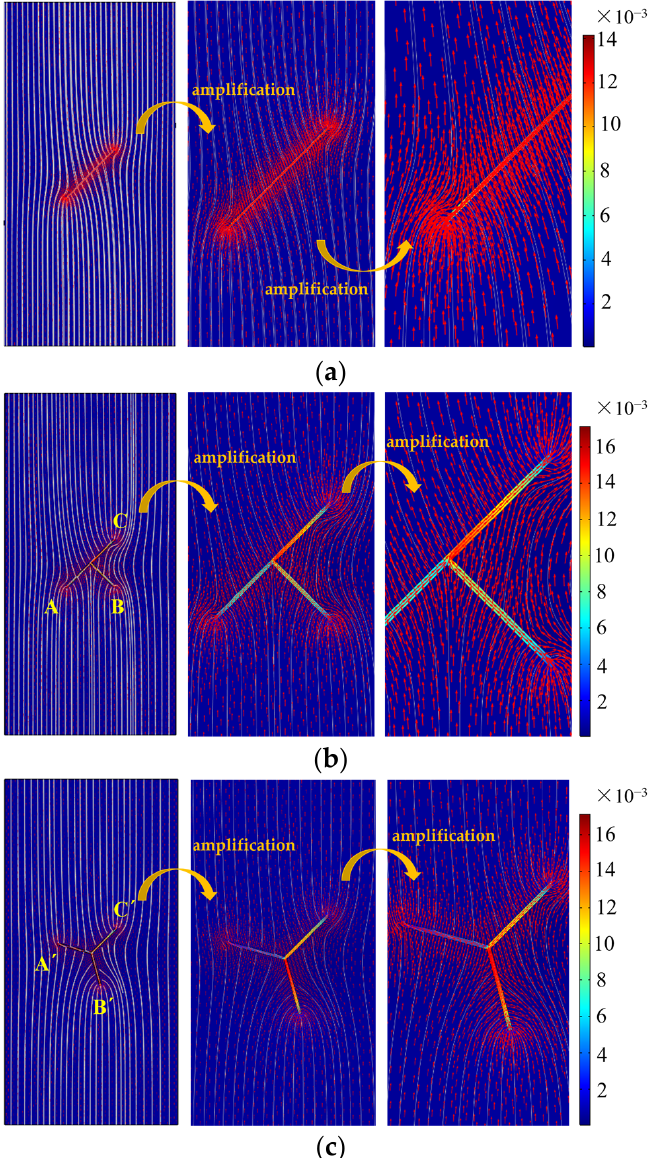
Figure 11. Seepage streamline trajectory distribution map: ( a ) Single fracture; ( b ) T ‐ shaped fracture; ( c ) Y ‐ shaped fracture.